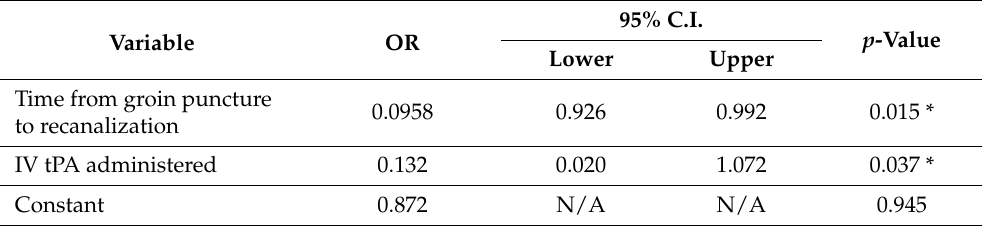
Table 3. Multivariate logistic regression of studied variables in predicting mTICI 2c/3 in all patients.